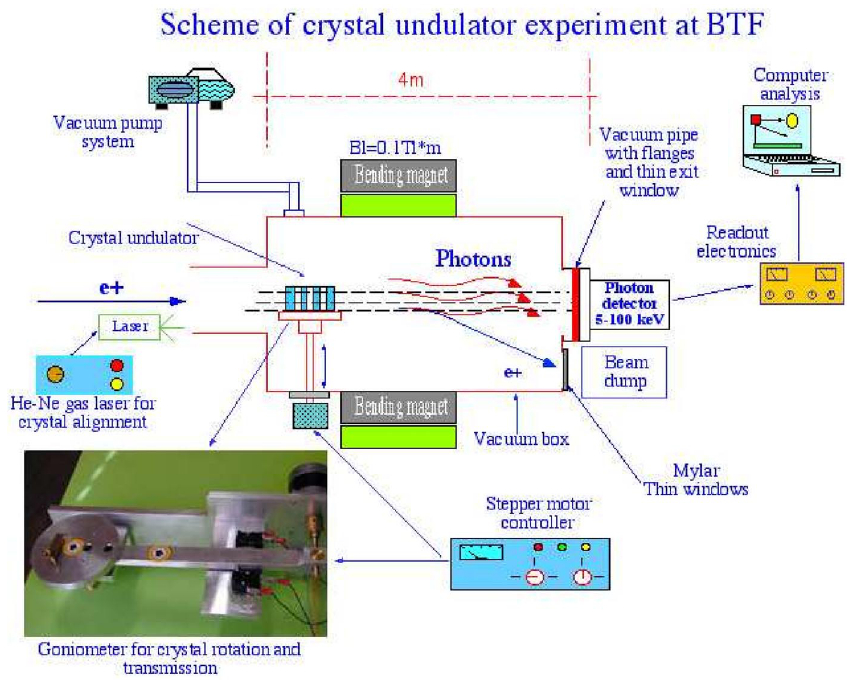
FIG. 5. (Color) The layout of the experiment on photon emission in the crystalline